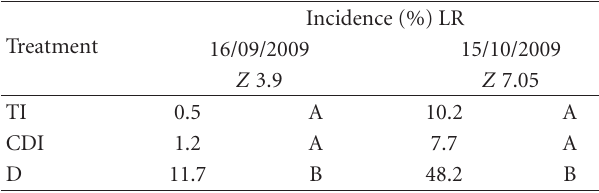
Table 4: Incidence (%) of (LR) for total irrigation (TI), irrigation with controlled deficit (CDI), and dry (D) treatments at di ff erent sampling dates in 2009.